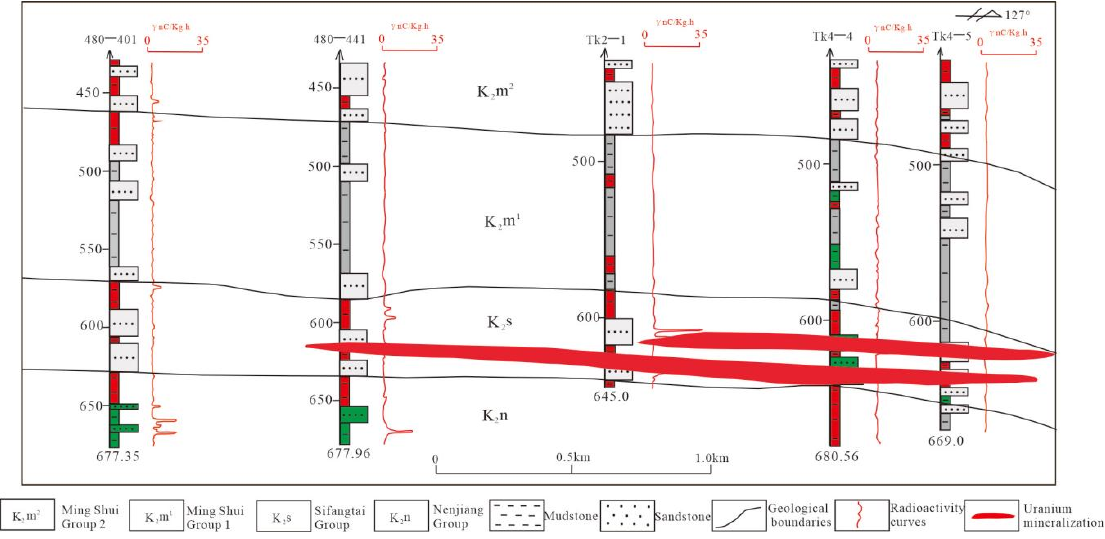
Figure 16. Uranium mineralization in the Sifangtai Formation, northern Songliao Basin.